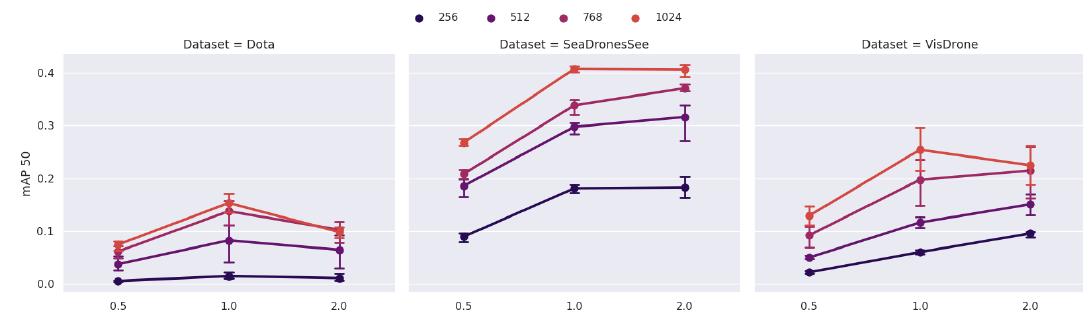
Figure A9. Image Size: EfficientDet trained with different training image sizes and validated on validation image size = x × training image size. The y-axis shows the mean Average Precision (mAP).